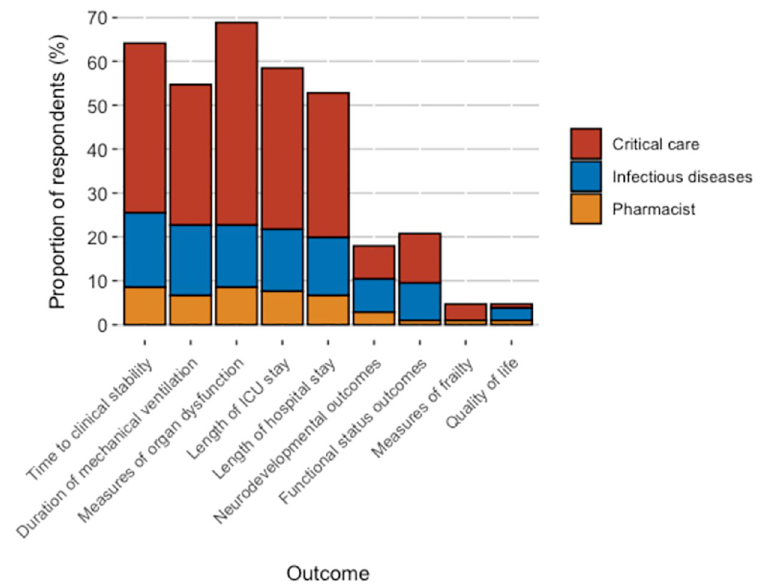
Fig 3. Outcomes in pediatric trials that could influence antibiotic treatment